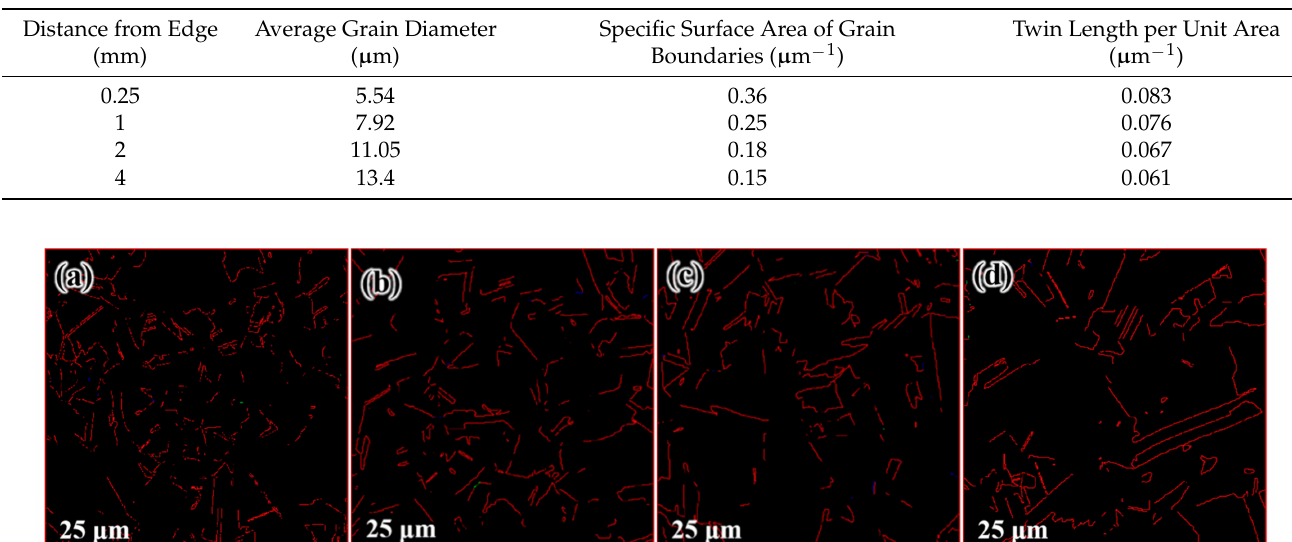
Figure 6. Distributions of microstructure after CE at 150 ◦ C: ( a ) 250 µ m from edge, ( b ) 1 mm from edge, ( c ) 2 mm from edge, and ( d ) 4 mm from edge. Table 1. The average grain diameter, specific surface area of grain boundaries, and twin length per unit area after CE at 150 ◦ C.